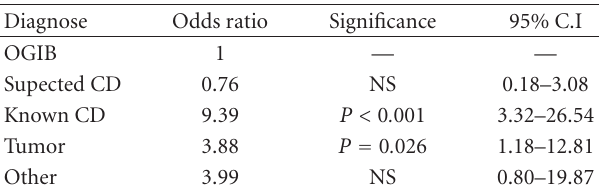
Table 3: Odds ratio of capsule retention of the capsule for di ff erent indications (adjusted for age and